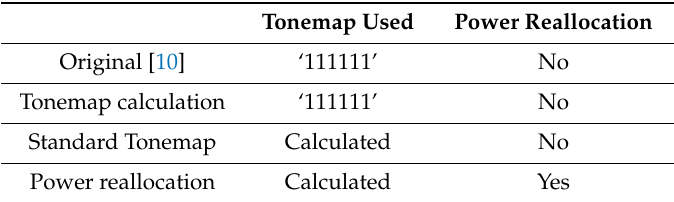
Table 3. Simulation parameters and steps for